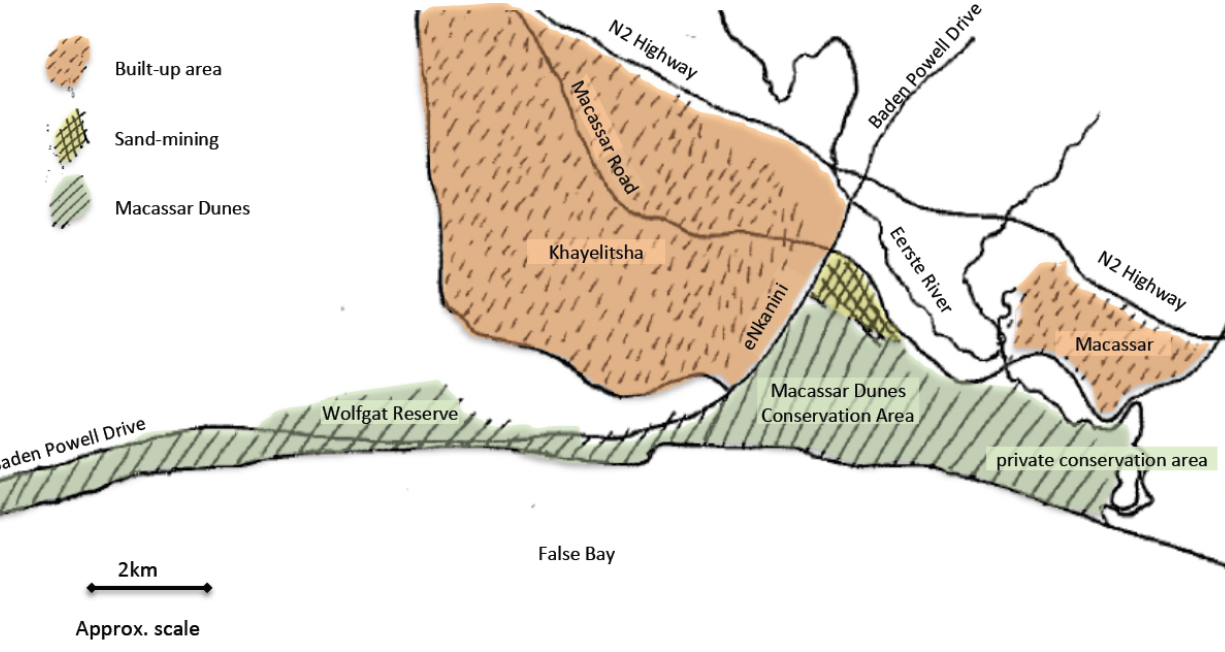
Fig. 2 . Macassar Dunes and surrounding area, showing the proximity of the Macassar and Khayelitsha townships, and eNkanini informal settlement. Enkanini is separated from the dunes by the coastal access road, which is called Baden Powell Drive. (Map not to exact